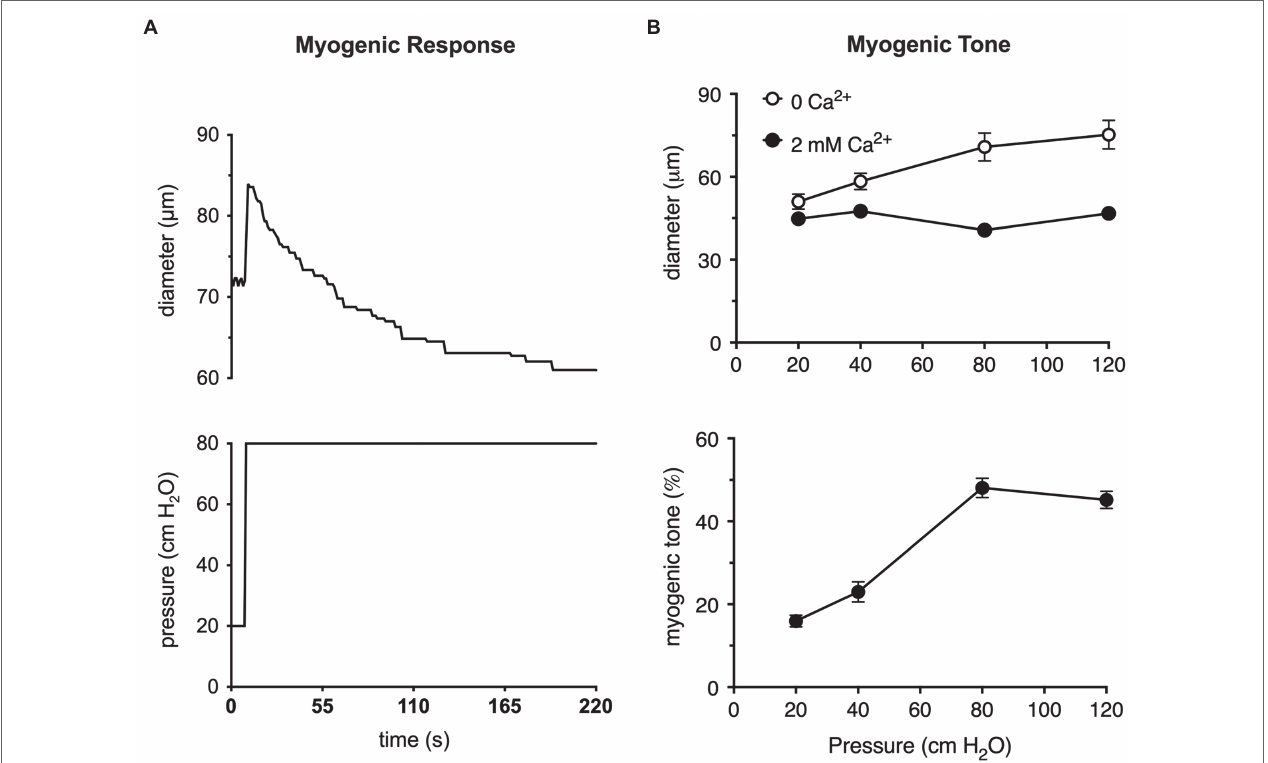
FIGURE 1 | The myogenic response and myogenic tone in arterioles. (A) Myogenic response in a cannulated hamster cremaster arteriole, ex vivo , prepared as described (Westcott and Jackson, 2011). Shown in the upper panel is a digitized diameter record of the response of a second-order cremaster arteriole to a step- increase in luminal pressure from 20 to 80 cm H 2 O as depicted in the lower panel. At the onset of the pressure step, arteriolar diameter increases due to passive distention of the vessel. As the smooth muscle responds and begins to contract, diameter recovers to a new steady-state diameter that is slightly less than the diameter at 20 cm H 2 O. This behavior is the myogenic response. (B) Myogenic tone in cannulated hamster cremaster arterioles. Top panel shows the steady-state diameters of arterioles at different pressures in the absence of extracellular Ca 2+ (passive) and presence of 2 mM Ca 2+ (active). Bottom panel shows the % myogenic tone at the given pressures computed from the data in the top panel as myogenic tone = (passive diameter–active diameter)/passive diameter × 100%. At pressures greater than 20 cm H 2 O, arterioles develop significant myogenic tone (i.e., steady-state pressure-induced constriction). Data in (A) are replotted from Jackson (2012), with permission. Data in (B) are replotted from Westcott and Jackson, (2011) and Jackson, (2012), with